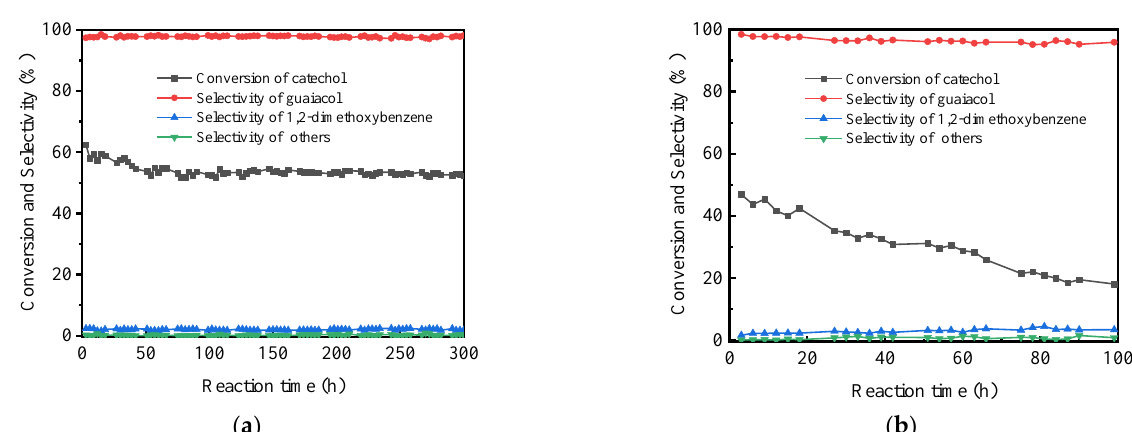
Figure 6. Stability test of ( a ) Al-1.1P-O catalyst and ( b ) Al-1.1P-O a . Reaction conditions: m cat = 6 g, Reaction temperature = 275 °C, LHSV = 0.6 h − 1 , methanol/catechol = 6 mol. Table 3. The textural properties of Al- x P-O and Al-1.1P-O a samples.